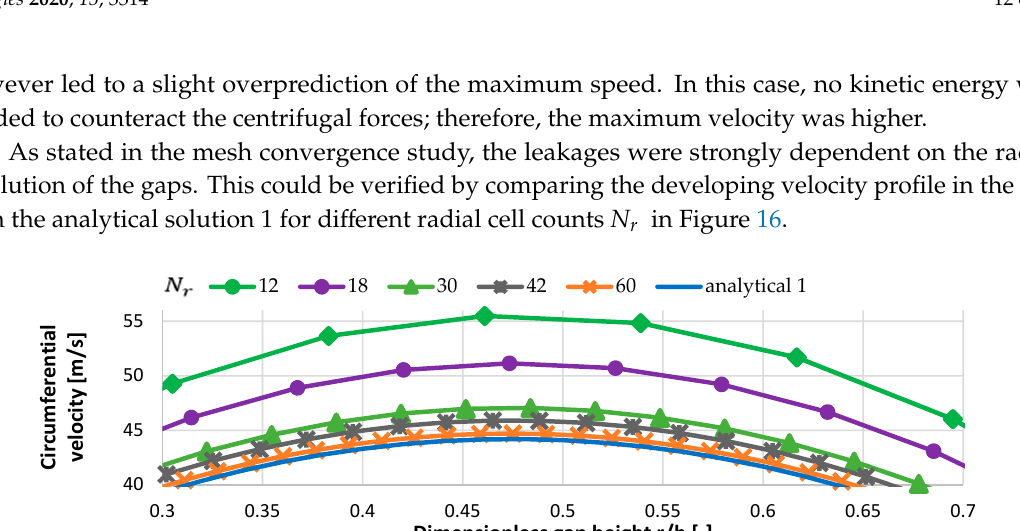
Figure 15. Comparison of the two analytically derived circumferential velocity profiles with the